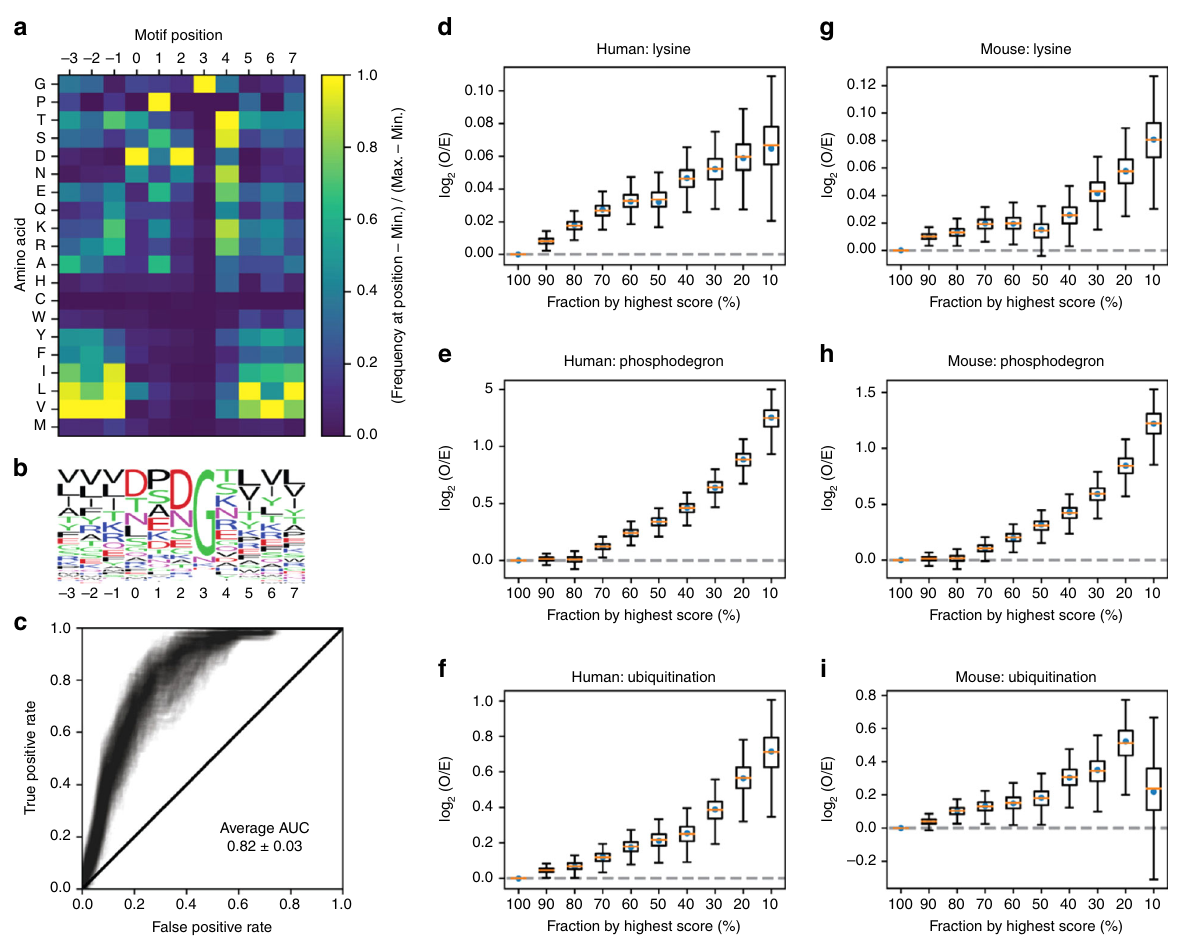
Fig. 8 Bioinformatic analysis of hairpin sequence motifs. a Sequence dependence of hairpin formation for the 11-residue linear motifs used to de fi ne the TPGGT hairpin turn, with motif position showing numbering relative to the TPGGT-associated positions of the turn. Colors show the relative hairpin propensity of each amino acid at each position, normalized to 1 (yellow) for the highest hairpin probability and 0 (black) for the lowest. b Sequence logo showing the underlying frequency distribution of panel a , from WebLogo 69 . c Receiver operating characteristic assessment of whether a hairpin turn derived PSSM can be used to predict hairpins for [TS]P x G containing sequences found in the PDB, gray lines showing true/false positive rates for 100 repeats of fi ve-fold cross validation (500 curves in total) with training/testing data split based on a list of 3870 nonredundant PDB chains. d – i Testing the ability of the hairpin prediction score to predict ubiquitination-related properties, with d , g showing local lysine enrichment (30 residues on either side fl anking the scored sequence), e , h showing overlap with two de fi ned phosphodegron motifs (as described in “ Methods ” section), and f , i showing ubiquitination events observed within 30 residues in the PhosphoSitePlus database 37 . Enrichment values were calculated separately for two proteomes, human d – f and mouse g – i , with observed enrichment shown by blue circles and bootstrap analysis (sampling against 6619 human and 5084 mouse proteins) used to calculate 99% con fi dence intervals (shown by whiskers), interquartile range (shown by boxes), and medians (shown by orange